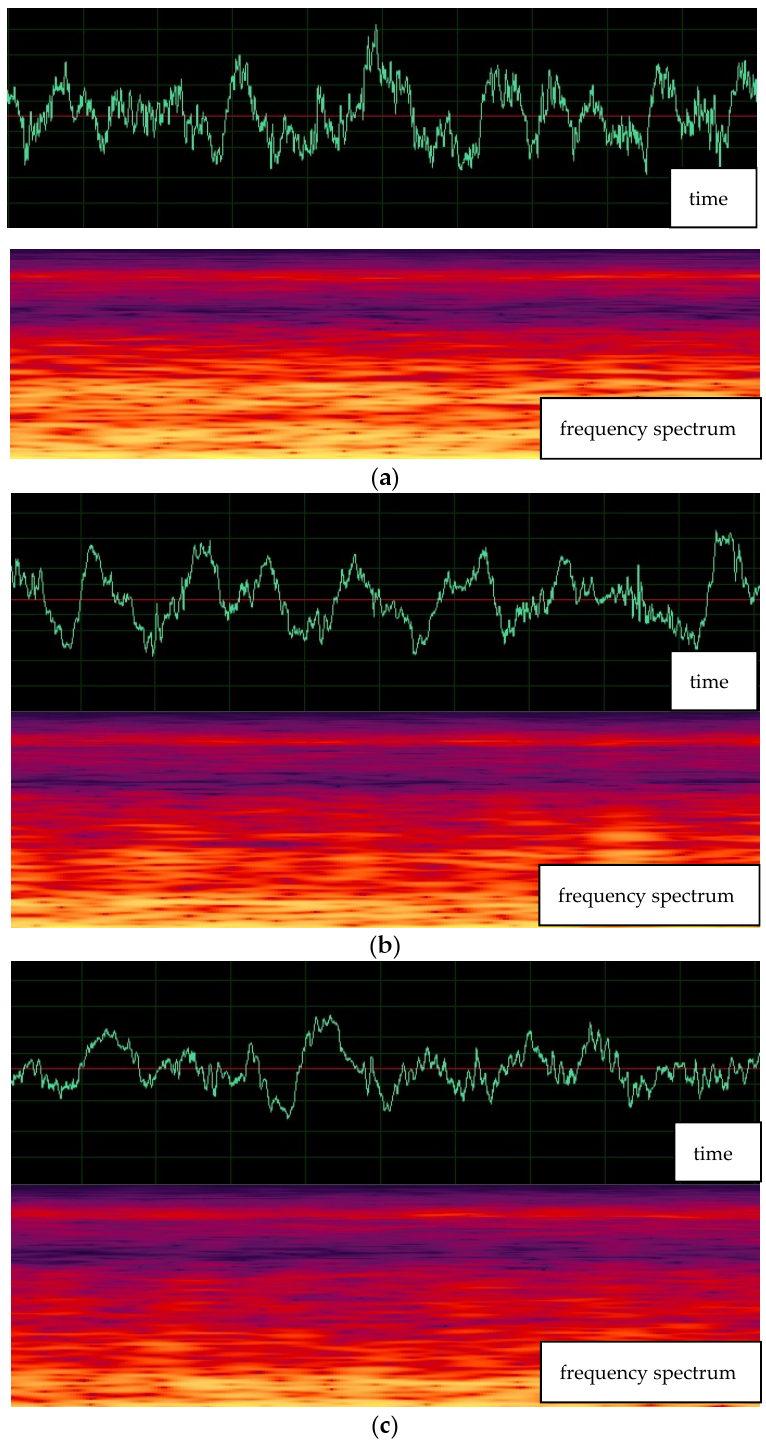
Figure 2. Time and frequency spectrum images from arc sound in the three penetration states. ( a ) Excessive penetration, ( b ) full penetration, and ( c ) non-penetration.